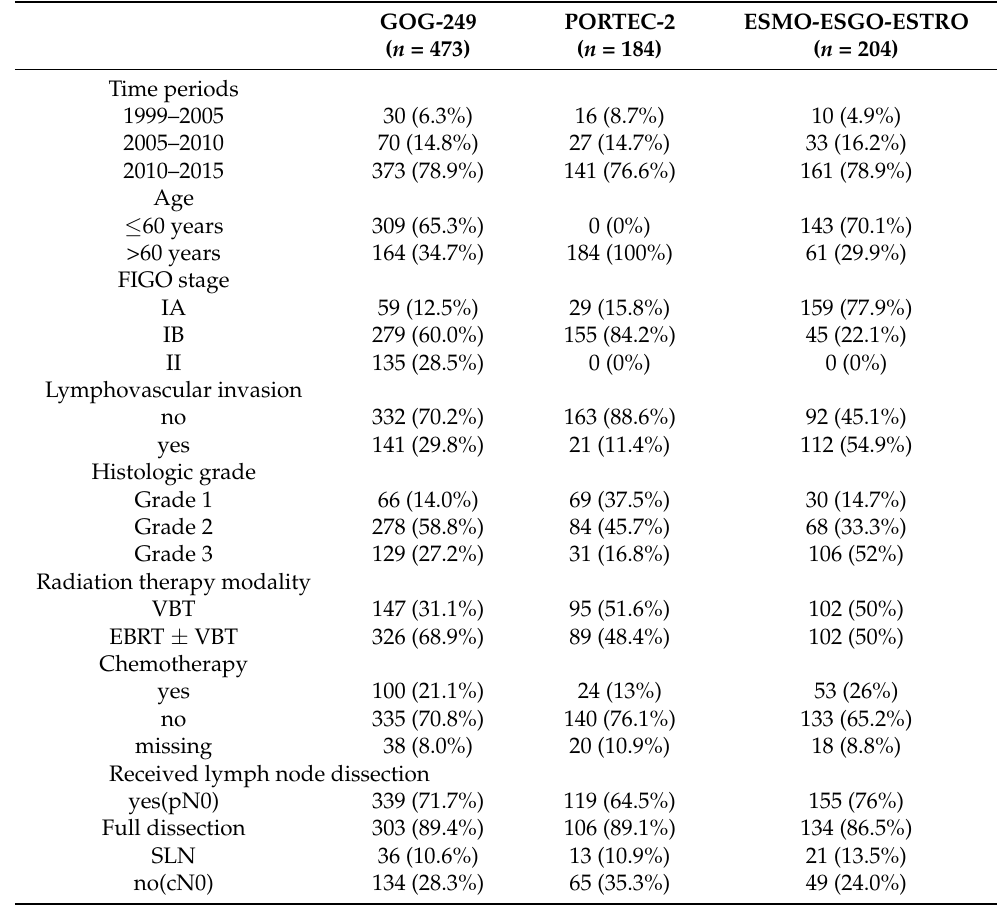
Table 1. Baseline characteristics of patients in the three HIR